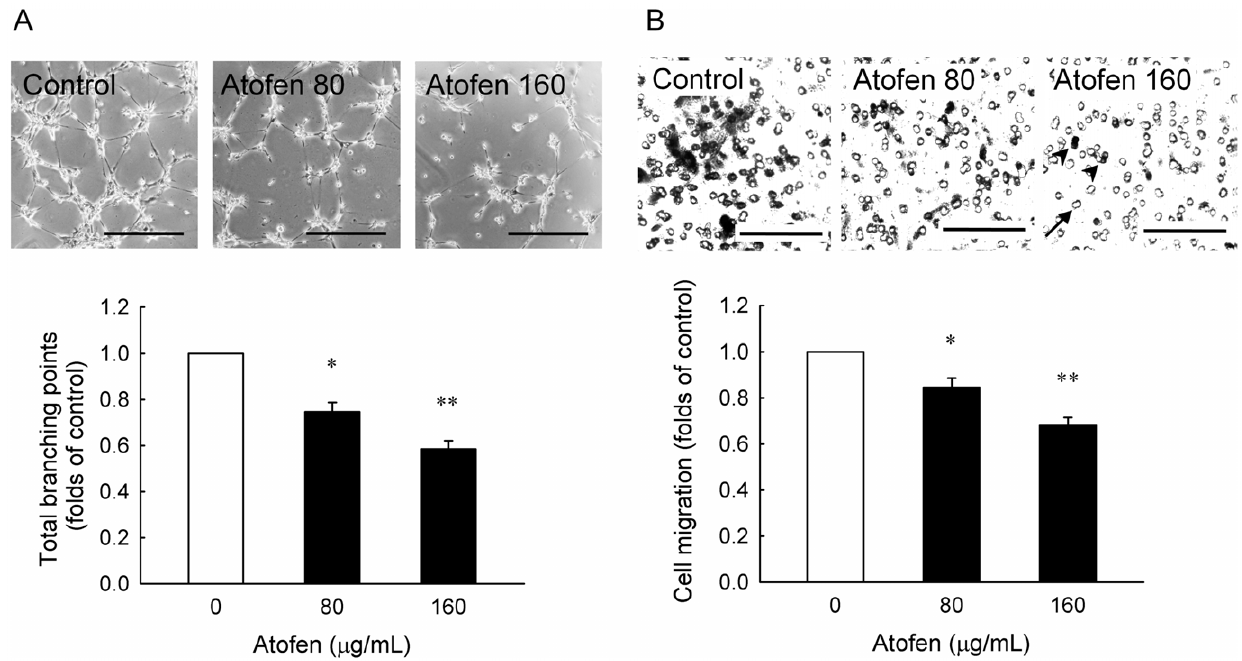
Figure 5. Iron inhibited tube formation and migratory capacity in HAECs. HAECs were treated with ferric chloride hexahydrate (Atofen) for 4 hours in tube formation (A) and 12 hours in cell migration (B). Values are expressed as mean 6 SEM. Scale bar represents 50 m m in Figure 5A and 30 m m in Figure 5B. The arrowheads indicate migrated endothelial cells and the arrow indicates membrane pore. * P , 0.05, ** P , 0.001 compared with baseline without Atofen treatment, n =3 in each group. Abbreviations: HAECs, human aortic endothelial cells.